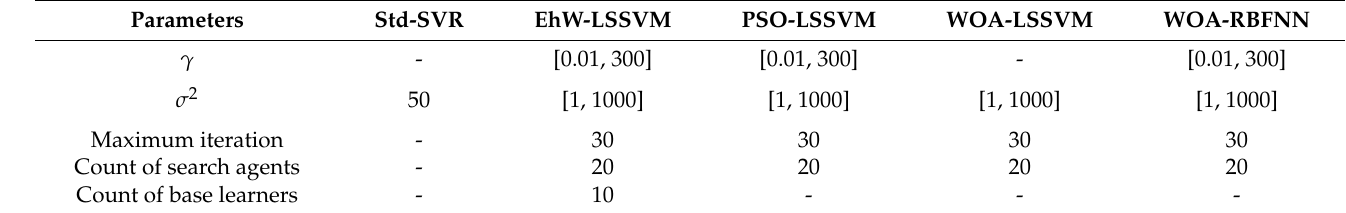
Table 2. Parameters of all